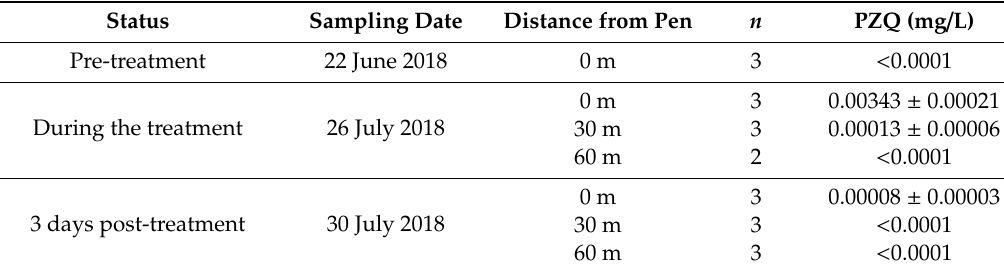
Table 1. Detection of praziquantel (PZQ) in water.